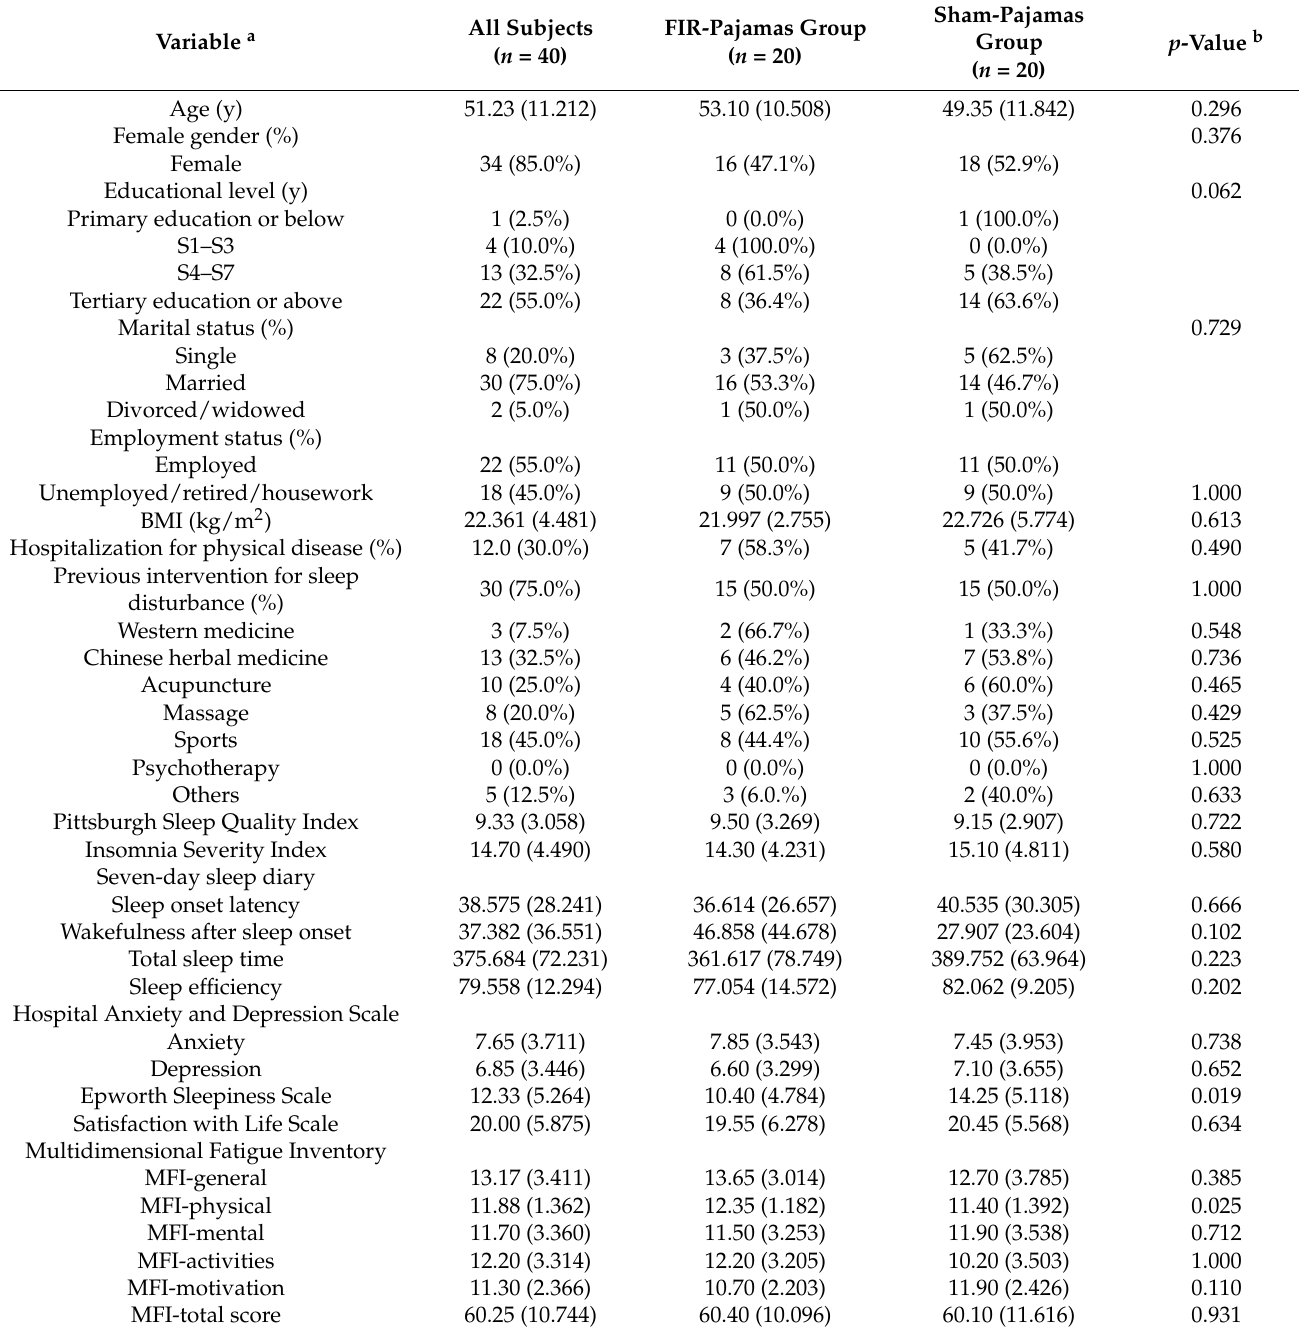
Table 1. Demographics and baseline characteristics of the two